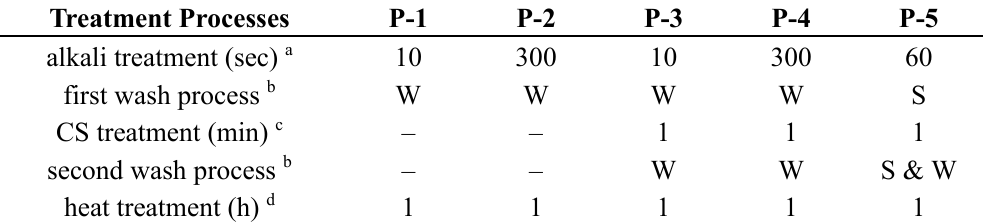
Figure 1. The schematic illustration of the process in this study. Table 1. Preparation data of PLA